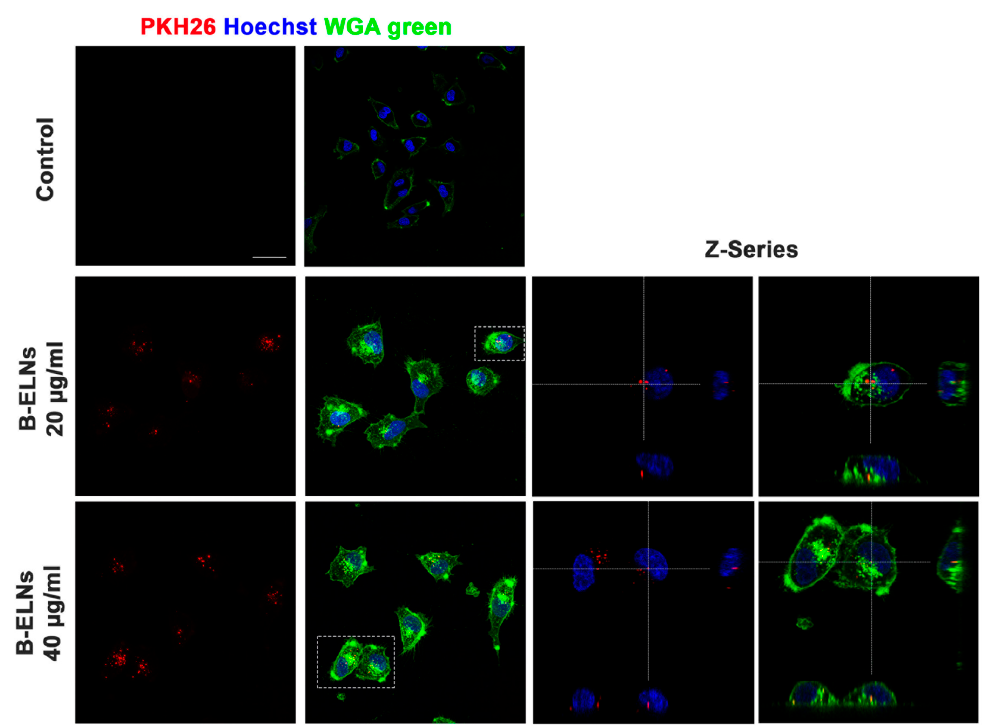
Figure 3. Analysis at confocal microscopy of EA.hy926 treated for 3 h with 20–40 µ g / mL of B-ELNs proteins, compared with cells exposed to vehicle (Control). Cells membrane was stained with Wheat Germ Agglutinin 488 (WGA), nuclear staining was performed using Hoechst (blue), B-ELNs were labeled with PKH26 (red). Representative images were collected using 40X resolution (bar 50 μ m) Z-series using 60× resolution (n = 3).